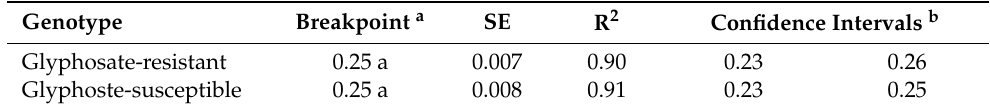
Table 2. Breakpoint (threshold value for the initiation of stomatal closure), standard error (SE), R 2 , and confidence intervals for the plateau regression analysis used to evaluate differences in drought tolerance between glyphosate-susceptible and -resistant Palmer amaranth ( Amaranthus palmeri (S.) Wats.) differing in EPSPS gene copy numbers; greenhouse experiment conducted at the Shult Agri-